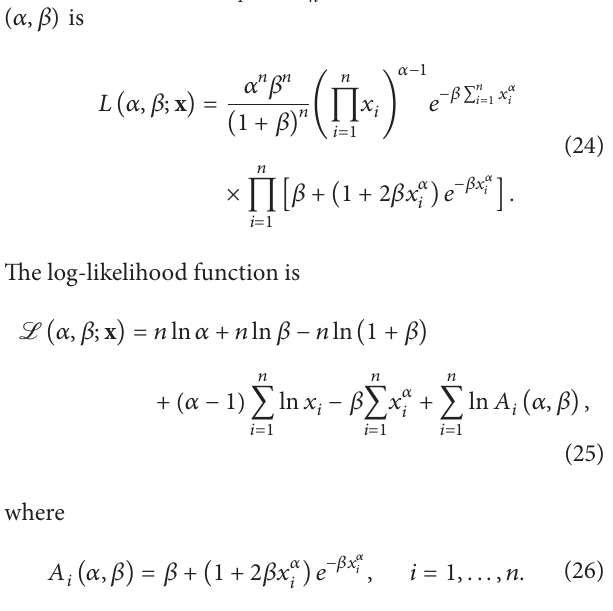
the items and let x = (𝑥 1 , . . . , 𝑥 𝑛 ) . The likelihood function for (𝛼, 𝛽)